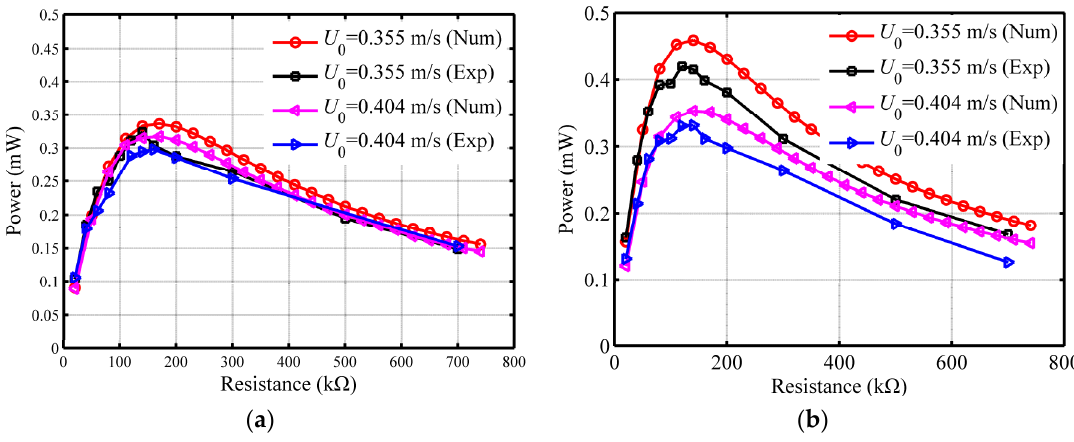
Figure 6. Numerical and experimental values of average power versus load resistance: ( a ) b = 20 mm; ( b ) b = 25 mm.